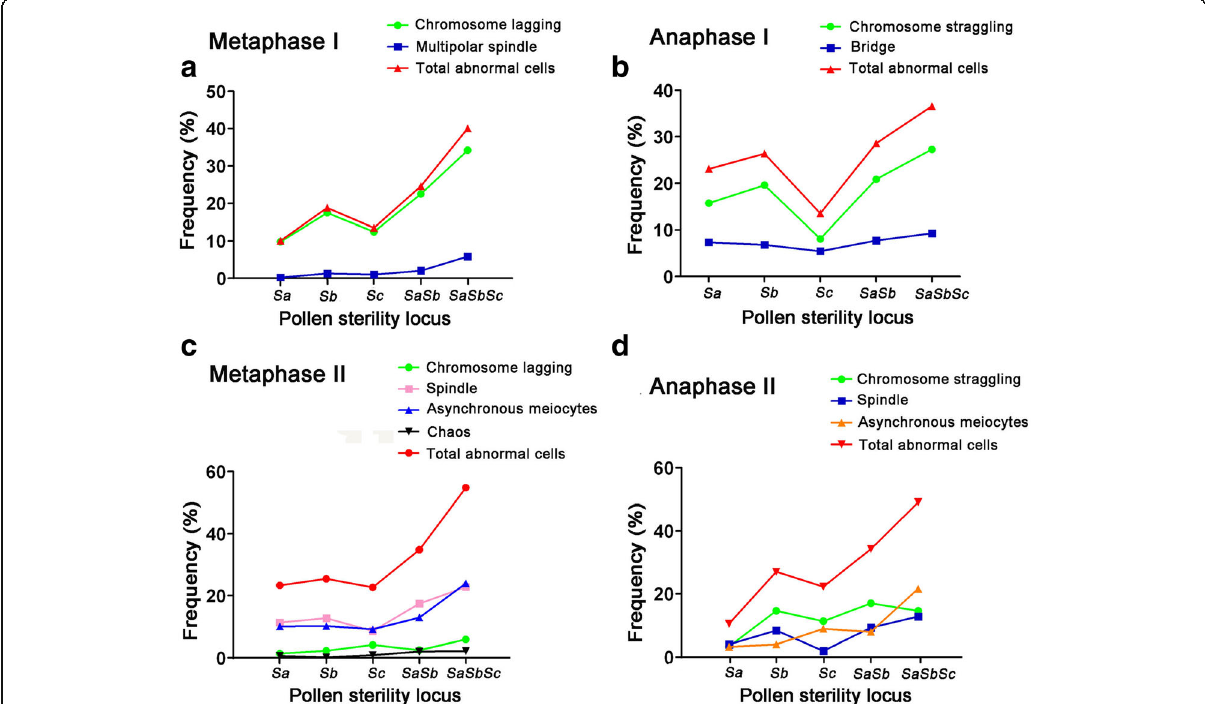
Fig. 3 Frequency of abnormal cells in different autotetraploid rice hybrids during PMCs meiosis. a Frequency of chromosome lagging, multipolar spindle and total abnormal cells in different autotetraploid rice hybrids at Metaphase I. b Frequency of chromosome straggling, bridge, and total abnormal cells in different autotetraploid rice hybrids at Anaphase I. c Frequency of chromosome lagging, spindle, asynchronous meiocytes, chaos and total abnormal cells in different autotetraploid rice hybrids at Metaphase II. d Frequency of chromosome straggling, spindle, asynchronous meiocytes, and total abnormal cells in different autotetraploid rice hybrids at Anaphase